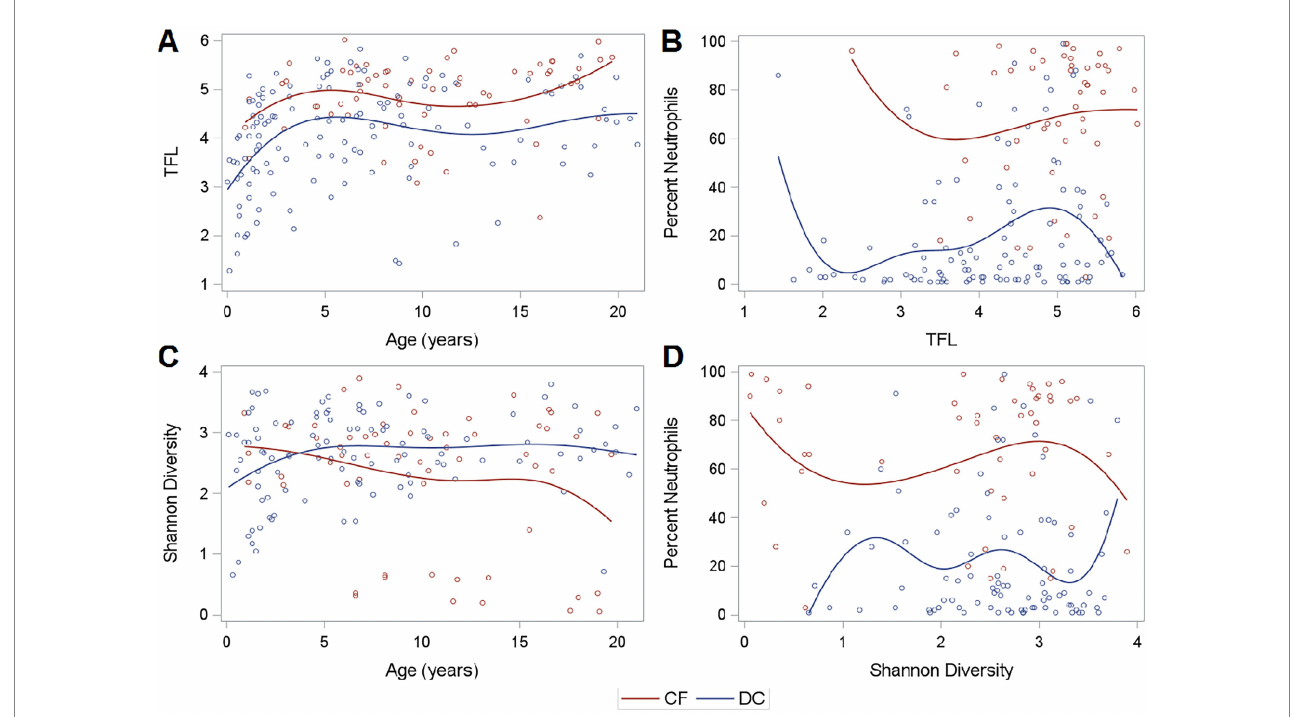
FIGURE 1 Total fungal load (TFL) by CF status and culture results. Distribution of TFL grouped by (A) CF status alone, and (B) CF status along with culture results. The box indicates the interquartile range (IQR; 25—75th percentile), and the median and mean are indicated by the lines and large circles, respectively. Whiskers indicate data within 1.5 times the IQR, and points indicate individual data values. TFL as measured by qPCR was higher in PWCF when compared to DC subjects (Wilcoxon, p < 0.01).